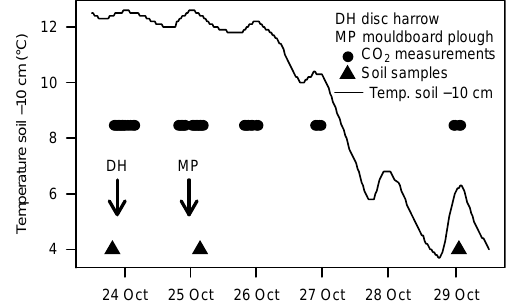
Figure 1. Timeline of the soil sampling and the CO 2 measurements in relation to the tillage events. Additionally, soil temperature at 10cm depth, which was recorded every 30min with an automated meteorological station (DALOS 535, F&C, Gülzow, Germany), is